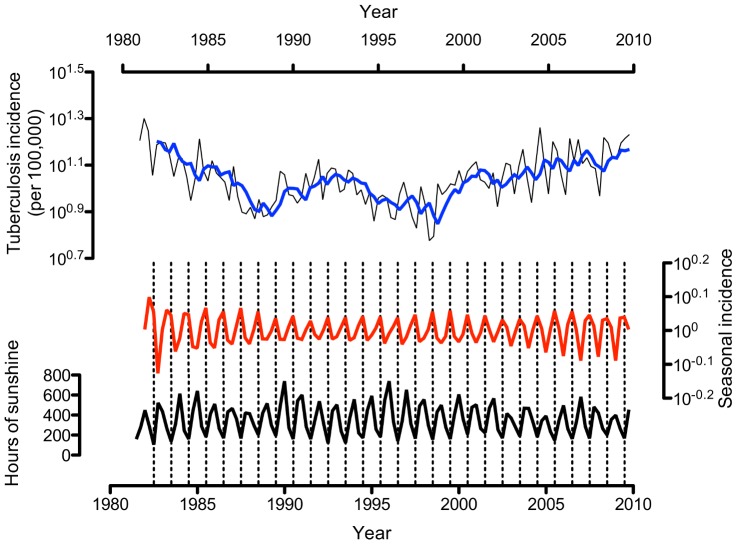
Total hours of sunshine and tuberculosis notifications.Note.– The thin black line above is the tuberculosis incidence per season. The tuberculosis incidence has been decomposed into a trend component (the thick blue line above) and a stochastic seasonal component (the thick red line across the middle of the graph). The thick black line below is the total hours of sunshine per season shifted two seasons (six months) to the right. Thin vertical interrupted lines mark the winter troughs in hours of sunlight. The graph shows that troughs in the total hours of sunshine per season correlate with peaks in the number of tuberculosis notifications two seasons later.